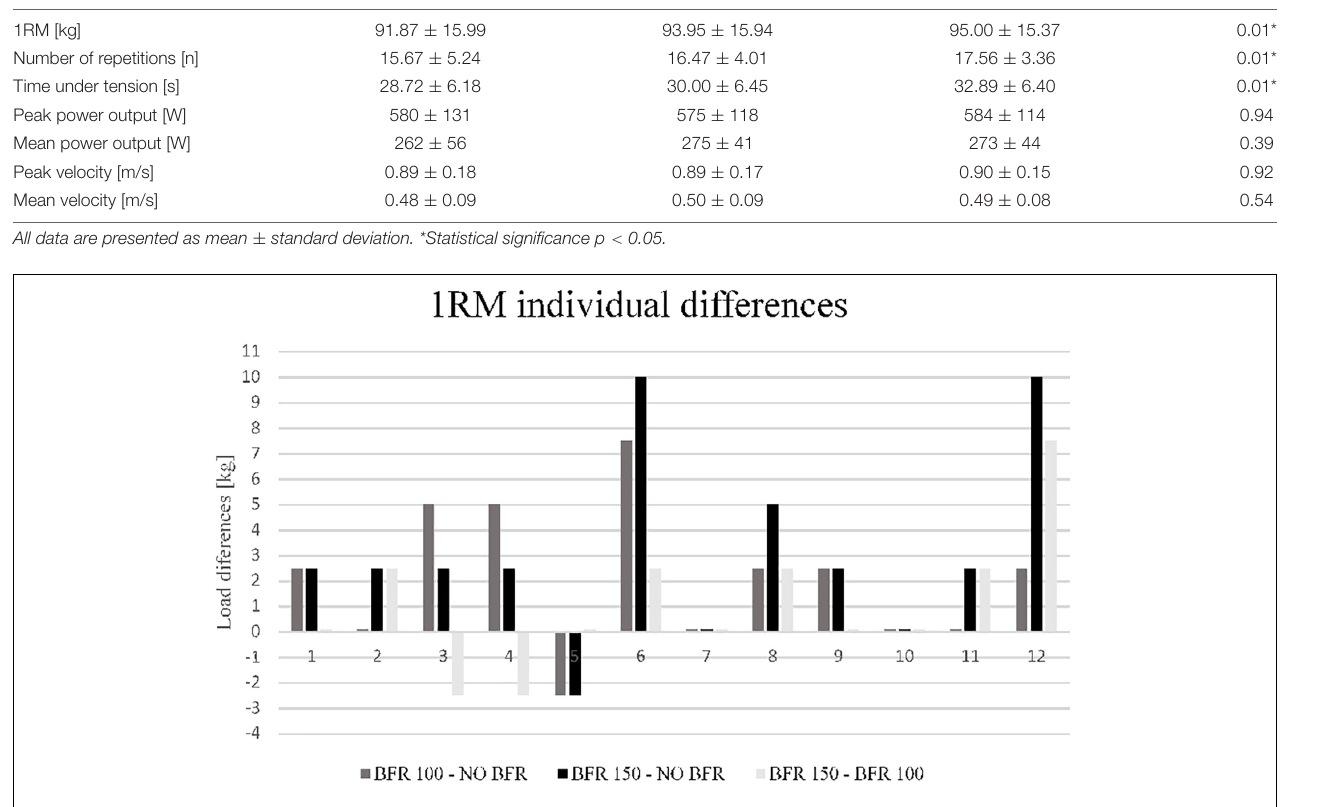
FIGURE 1 | Individual responses for the IRM test between